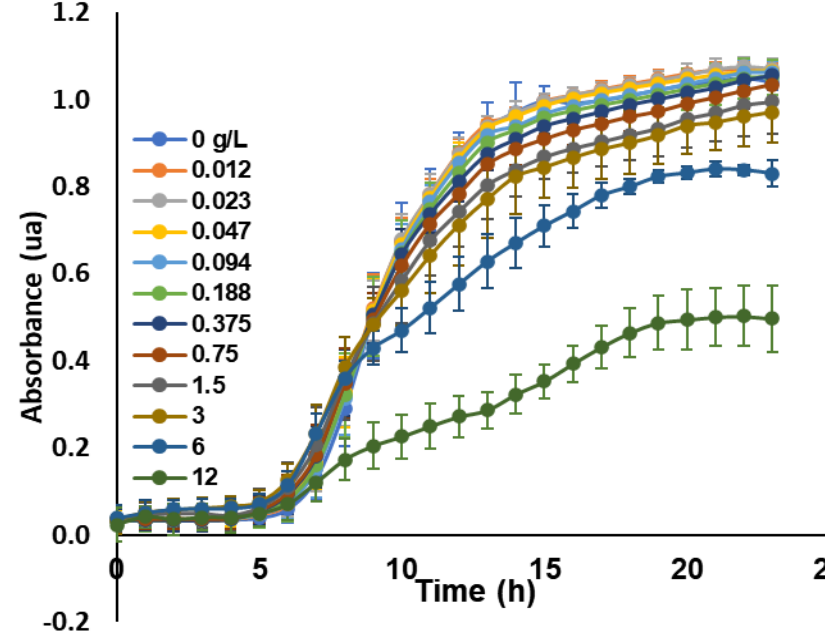
Figure 16. Growing of bacteria in the presence of CMCs-HEC (negative control).